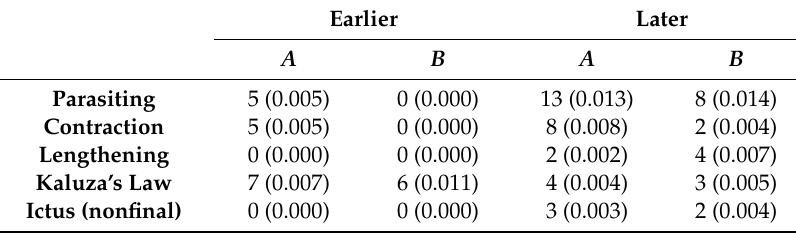
Table 7. Incidence of dating criteria in Andreas A and B 13